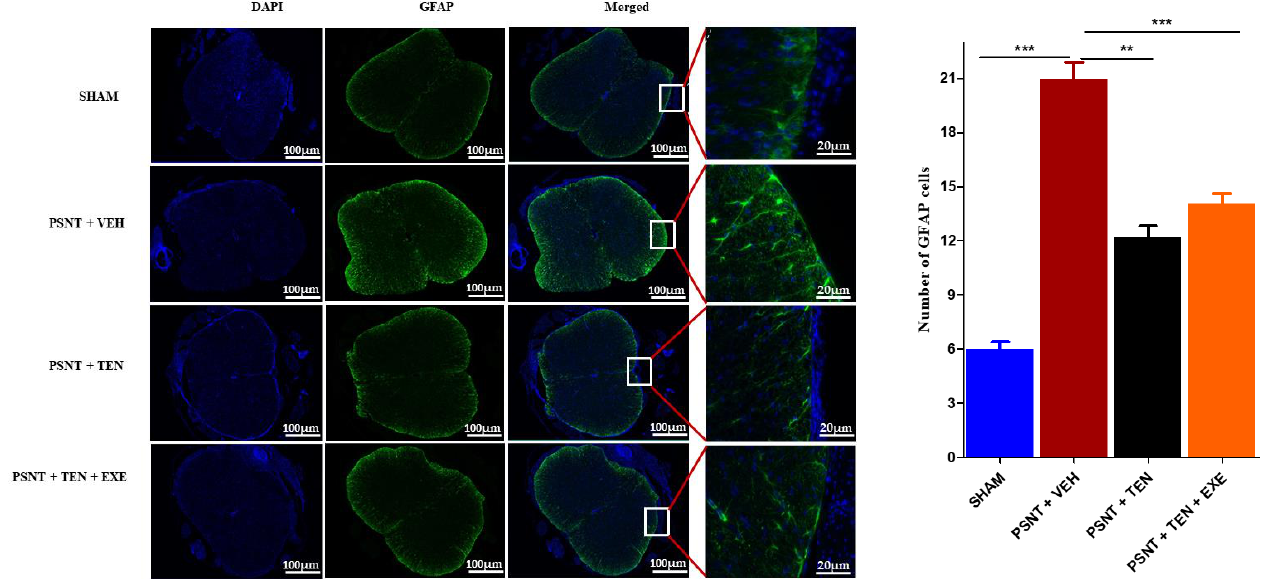
Figure 4. Effects of TEN administration on PSNT-induced glial fibrillary acidic protein (GFAP, astrocytic marker) expression in rat spinal cords. On day 7 after, spinal cord sections were fixed and single-labeled with fluorescein isothiocyanate-labeled anti-GFAP antibodies (green; astrocytes) and the nuclei were counterstained with 4 (cid:48) ,6-diamidino-2-phenylindole (DAPI) (blue), then images were captured and merged by fluorescence microscopy. The sections were from sham rats, PSNT + vehicle infused rats, and PSNT + TEN infused rats. The green fibers indicate activated astrocytes. Asterisk denotes a statistically significant difference between sham vs. PSNT + Veh, PSNT + Veh vs. PSNT + TEN, and PSNT + TEN vs. PSNT + TEN + EXE. ** p < 0.01; *** p < 0.001, ( n = 6 animals per